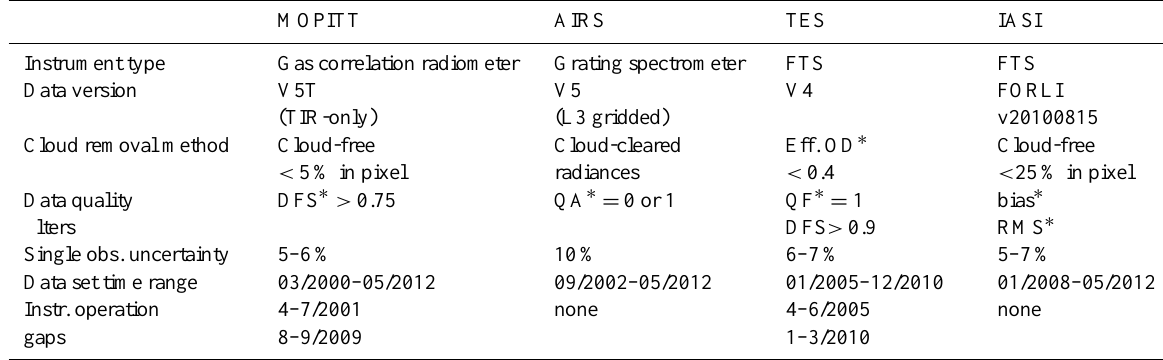
Table 2. Data selection information by instrument. Single observation uncertainty is the average retrieval error for individual total column CO